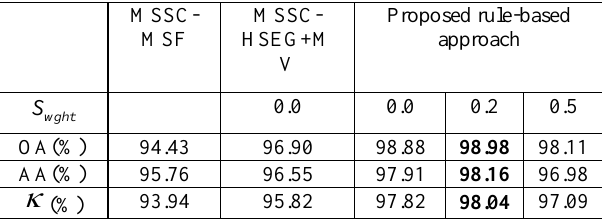
Table 1.Classification Accuracies for the Center of Pavia Image: Overall Accuracy (OA), Average Accuracy (AA), Kappa Coefficient (κ), The highest accuracies are bolded in each